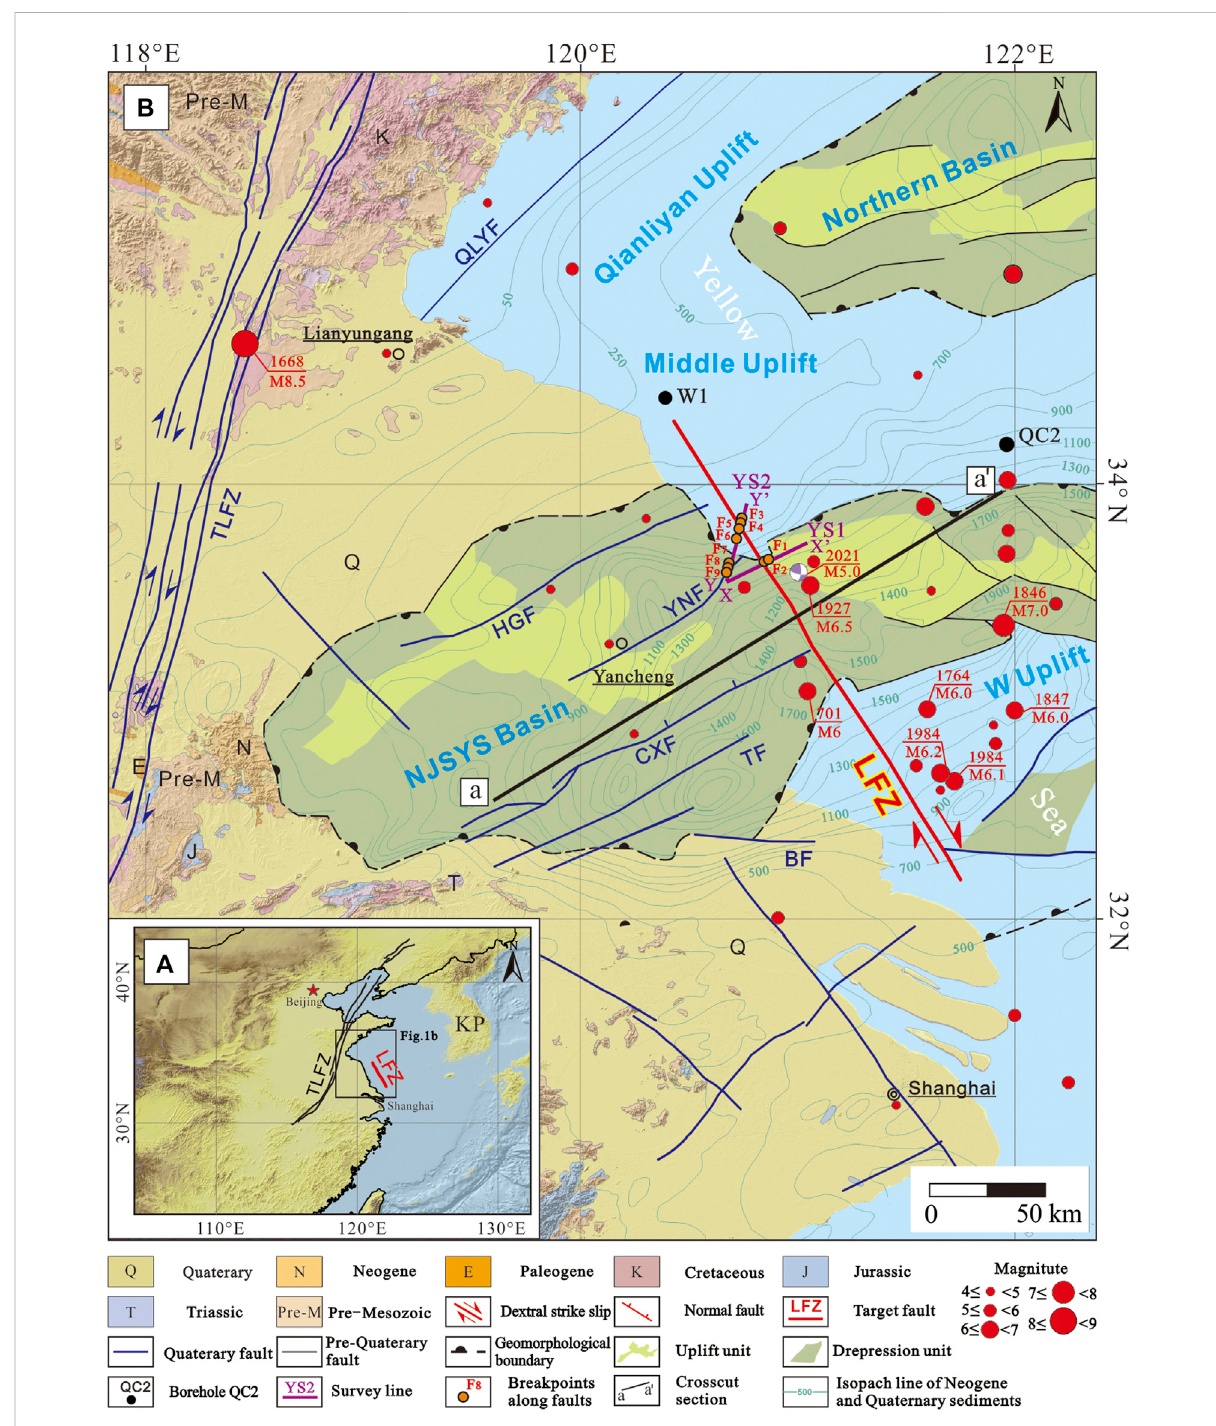
FIGURE 1 (A) Mapshowingtheoverall tectonic setting around theLFZ.KP: Korean Peninsula; LFZ: thelittoral fault zoneattheNorthern Jiangsu Province; TLFZ: the Tanlu fault zone; (B) geological and geomorphic maps around the LFZ. HGF: the Hongze – Goudun Fault; CXF: the Chenjiabao – Xiaohai Fault; BF: the Bingchahe Fault; TF: the Taizhou Fault; YNF: the Yancheng – Nanyangan Fault; QLYF: the Qianliyan Fault; NJSYS Basin: the Northern Jiangsu – south Yellow Sea Basin; W Uplift: Wunansha